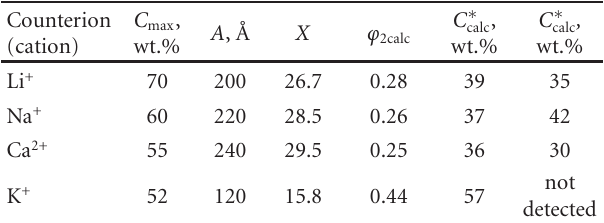
Table 5: Characteristics of endothermic e ff ect registered on the Na- CAS solutions’ DSC